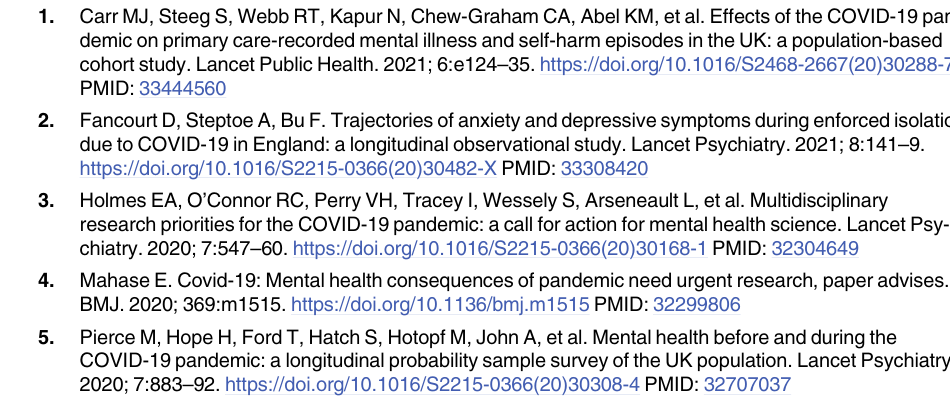
S3 Fig. Trends of depressive (weighted percentages in 5 categories) and anxiety symptoms (weighted percentages in 4 categories) over time from March 2020 to March 2022. (DOCX) S4 Fig. Correlation matrix of predictors across study periods (unweighted).